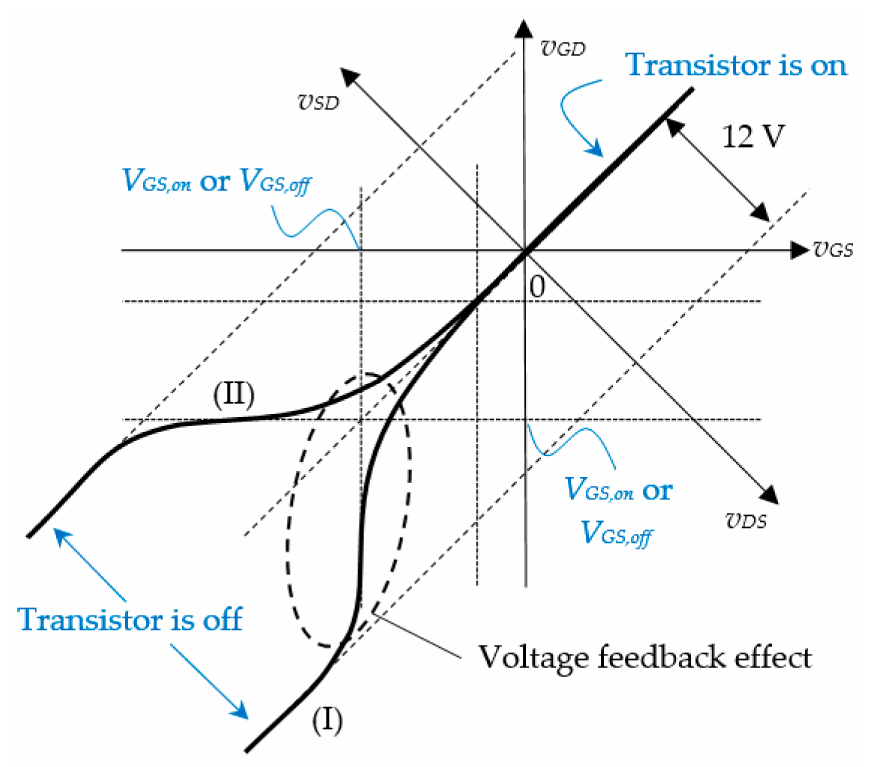
Figure 4. The triangular wave on–off traces of a D-mode GaN